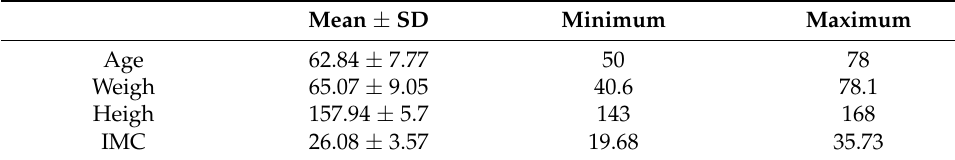
Table 1. Anthropometric characteristics of participants.